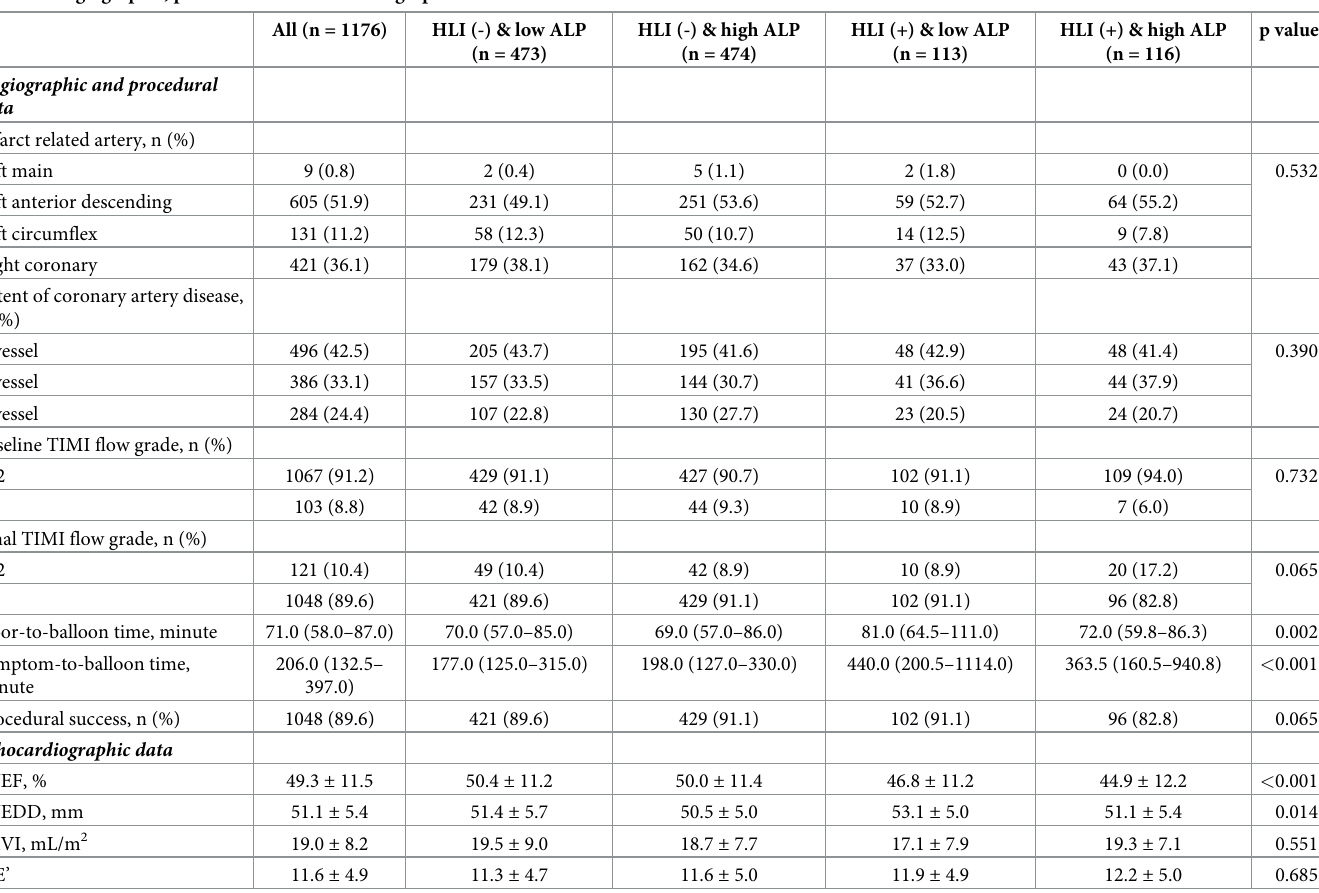
Table 2. Angiographic, procedural and echocardiographic data.